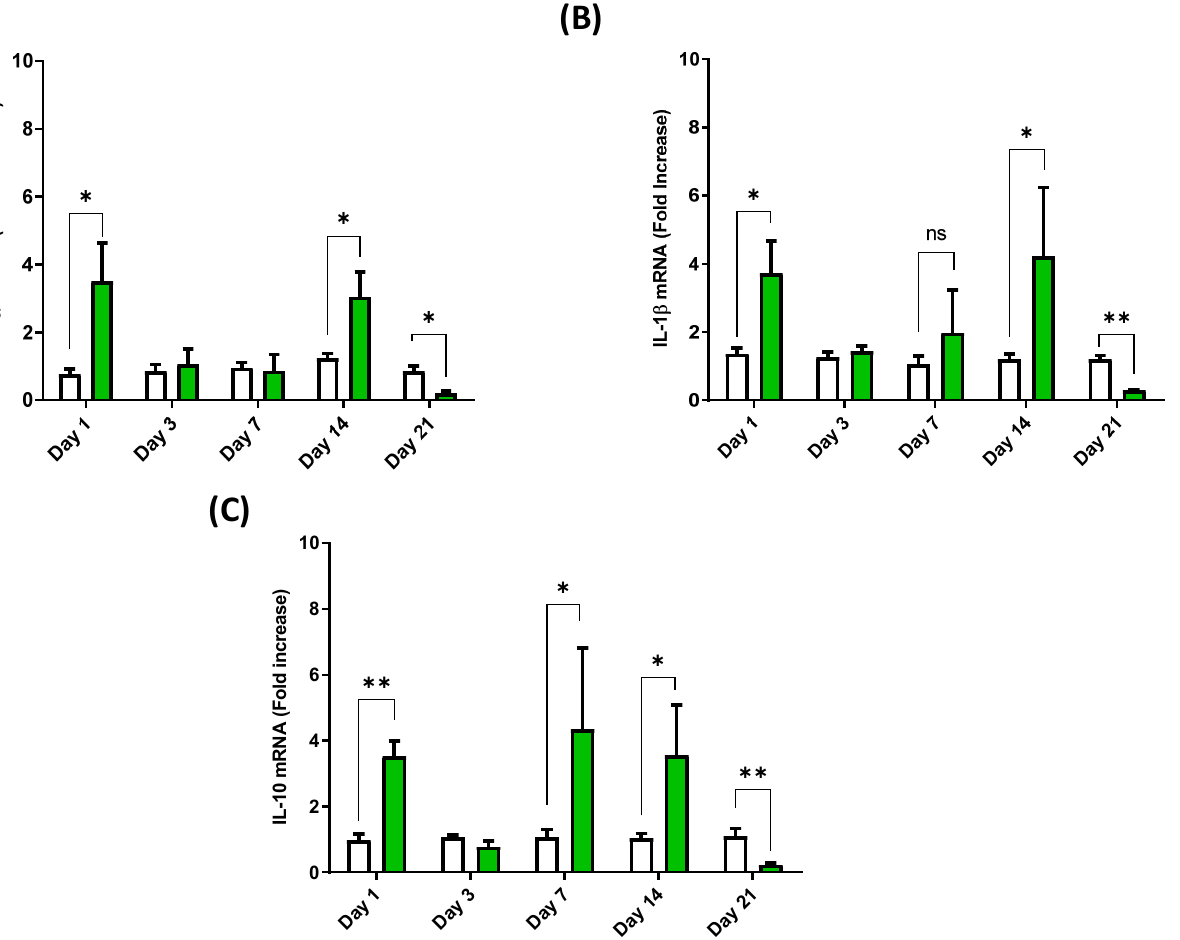
Figure 3. Spleen cytokine mRNA expression profile of European sea bass injected with Hep20. TNF α ( A ), IL-1 β ( B ) and IL-10 ( C ) mRNA expression in the spleen of European sea bass after Hep20 intraperitoneal injection (green bars). The graph shows the cytokine fold induction compared to the control group, i.e., fish injected with phosphate-buffered saline (white bars). Significant differences ( p < 0.05 or p < 0.01) between groups at each time are indicated by (*) or (**) respectively ( n = 6), ns (non-significant differences).